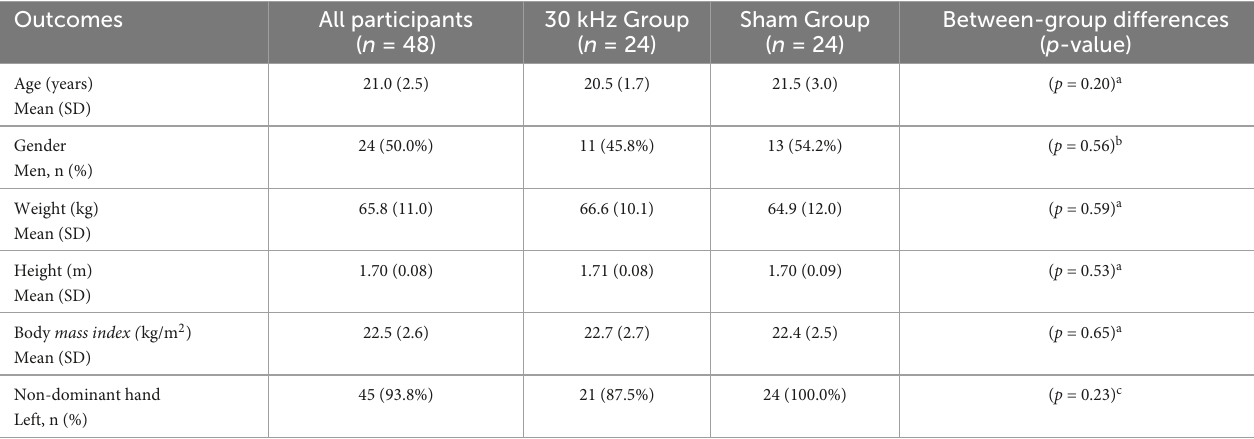
TABLE 1 Demographic characteristics of participants at the baseline. Outcomes All participants